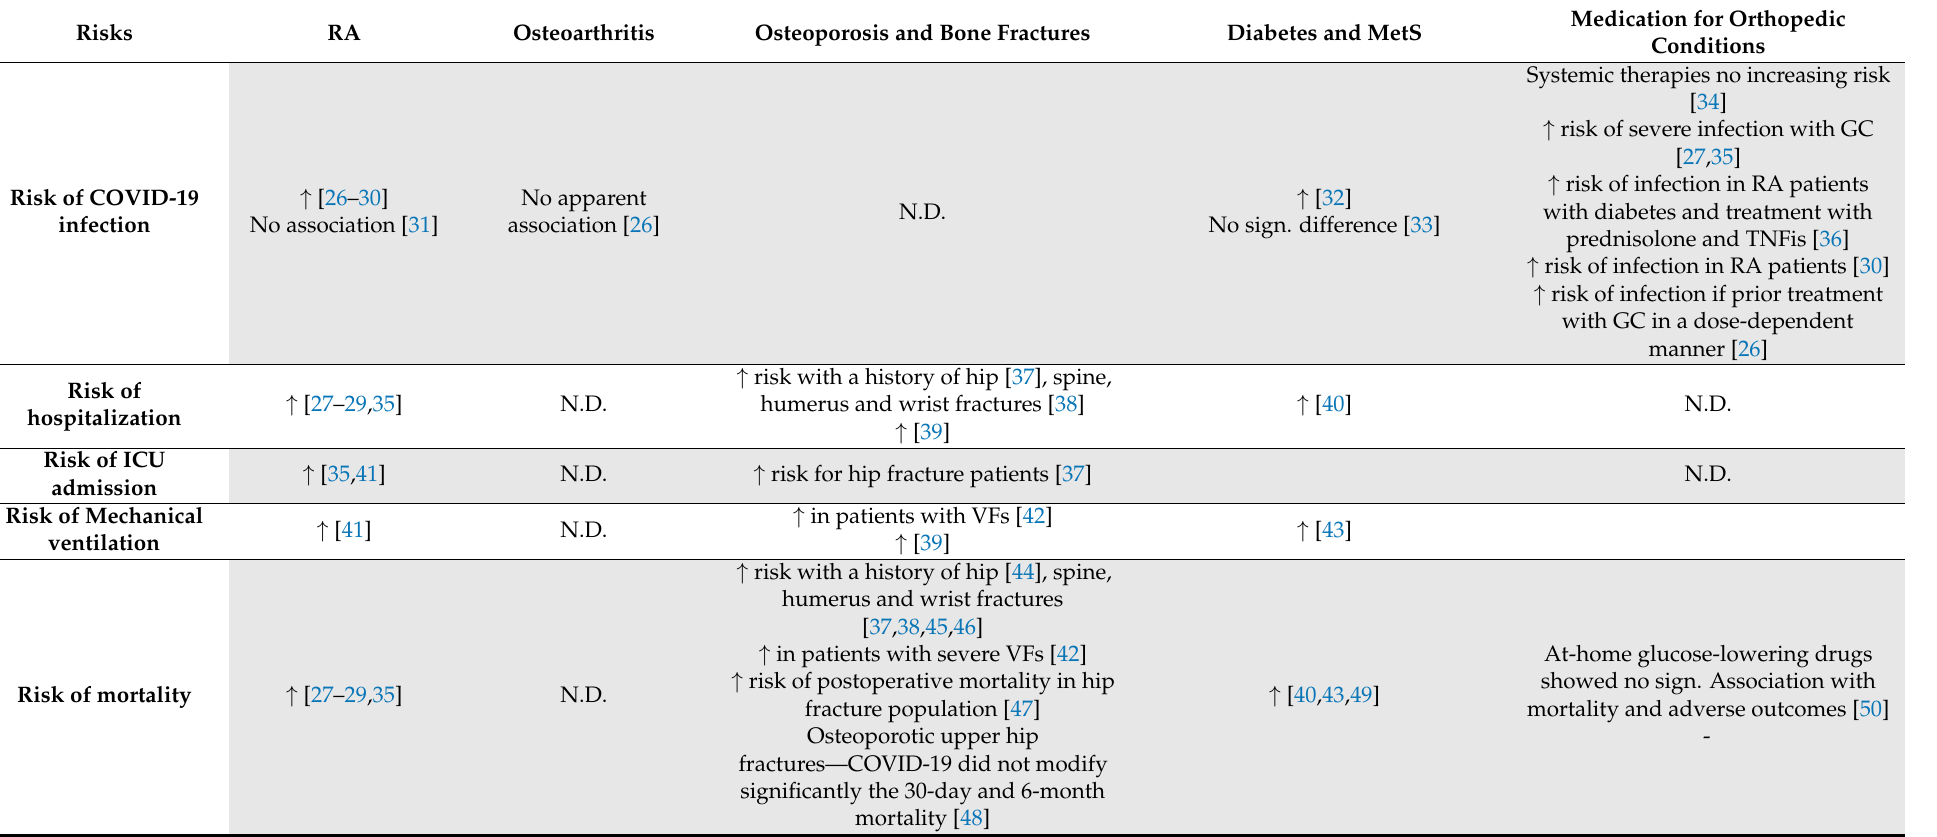
Table 1. Orthopedic conditions and the risks associated with COVID-19